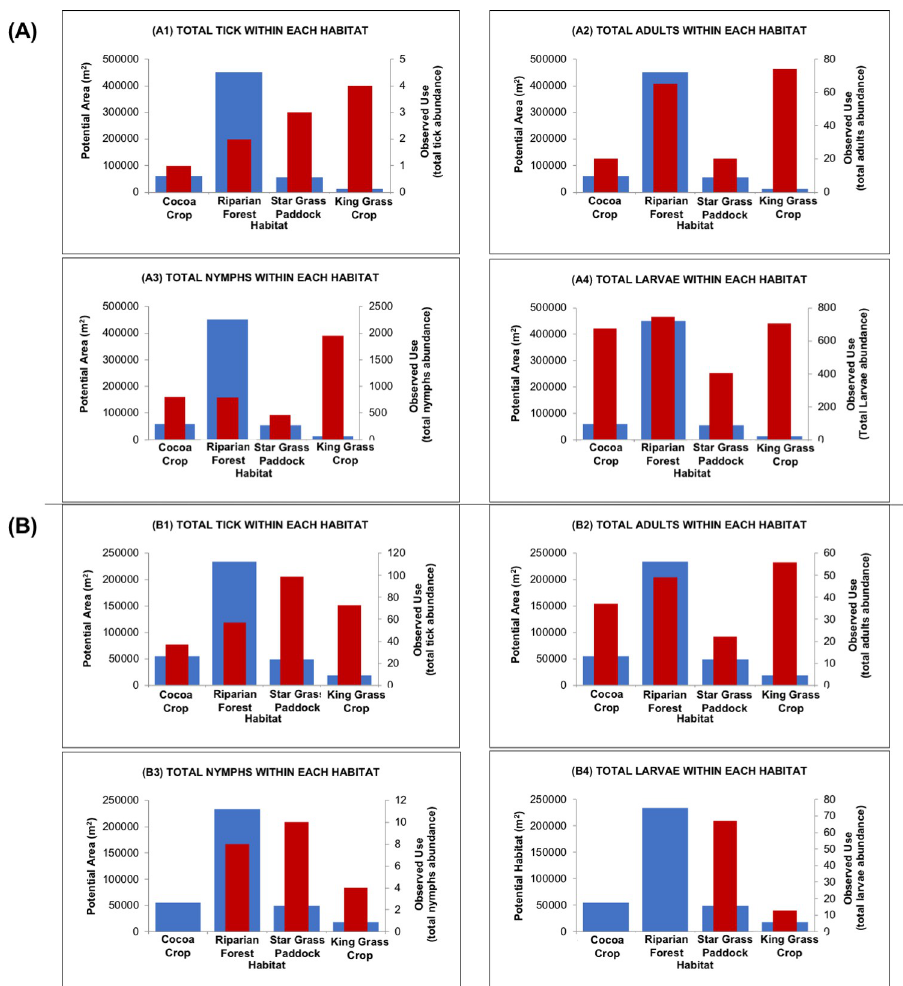
Fig 5. Trend graphs to infer the use and habitat preference of A . mixtum . These plots relate tick total abundance and tick stage abundance of both dry and wet seasons, (as an equivalent of observed use of each habitat resources) (red bar ∎ ; frequency on the y’-axis on the right) and the potential or available area of the habitat that A . mixtum might use (blue bar ∎ ; frequency on the y-axis on the left) at the Matepanano farm. Thus, the higher the red bar and the lower the blue bar, the greater the habitat preference. When the red bar barely exceeds or equals the blue bar, the relationship corresponds to habitat usage. When the blue bar far surpasses the red bar, there is avoidance of such a habitat (see tables 3–5). (A). Dry season. (A1) The mathematical index points out that A . mixtum uses all four habitats. In addition, A . mixtum population (stage independent) uses three habitats and shows preference for Star Grass Paddock and King Grass Crop, while it avoids the Riparian Forest habitat. (A2) Adults of A . mixtum prefer King Grass Crop, while they use the remainder habitats. (A3) Nymphs of A . mixtum prefer King Grass Crop and Cocoa Crop; they use Star Grass Paddock, but they avoid the Riparian Forest habitat. (A4) Larvae of A . mixtum prefers three habitats (King Grass Crop, Cocoa Crop, and Star Grass Paddock), while they only use the Riparian Forest habitat. (B). Wet season. (B1) A . mixtum population (stage independent) prefers King Grass Crop and Star Grass Paddock; it uses Cocoa Crop and avoids Riparian Forest. (B2) Adults of A . mixtum prefer King Grass Crop and Cacao Crop, while they use Star Grass Paddock and Riparian Forest. (B3) Nymphs of A . mixtum uses Cocoa Crop; they prefer Star Grass Paddock and King Grass Crop, and they avoid the Riparian Forest habitat. (B4) Larvae of A . mixtum only uses two out of four habitats, preferring the Star Grass Paddock, and using the King Grass